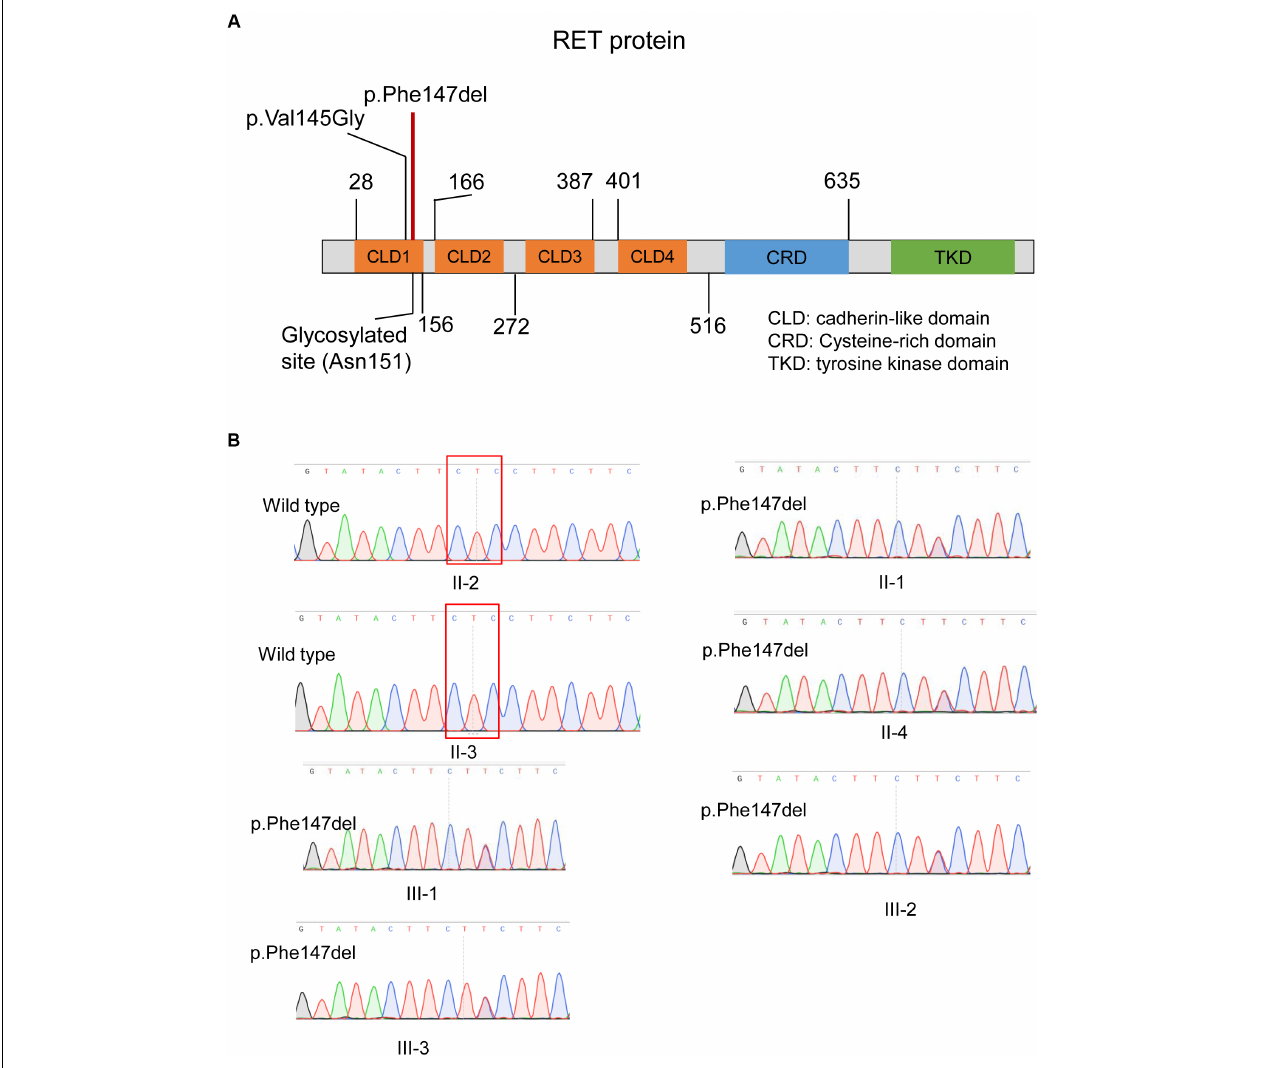
FIGURE 4 | The in-frameshift disease-causing variant in the RET protein structure and validation of this variant by Sanger sequencing. (A) The in-frameshift disease-causing variant p.Phe147del in RET is located within the CLD1 domain. (B) The in-frameshift variant in RET (p.Phe147del) in four patients and one unaffected carrier, and two unaffected members with wild genotype are validated by Sanger sequencing. The deleted three bases were enclosed by the red box.